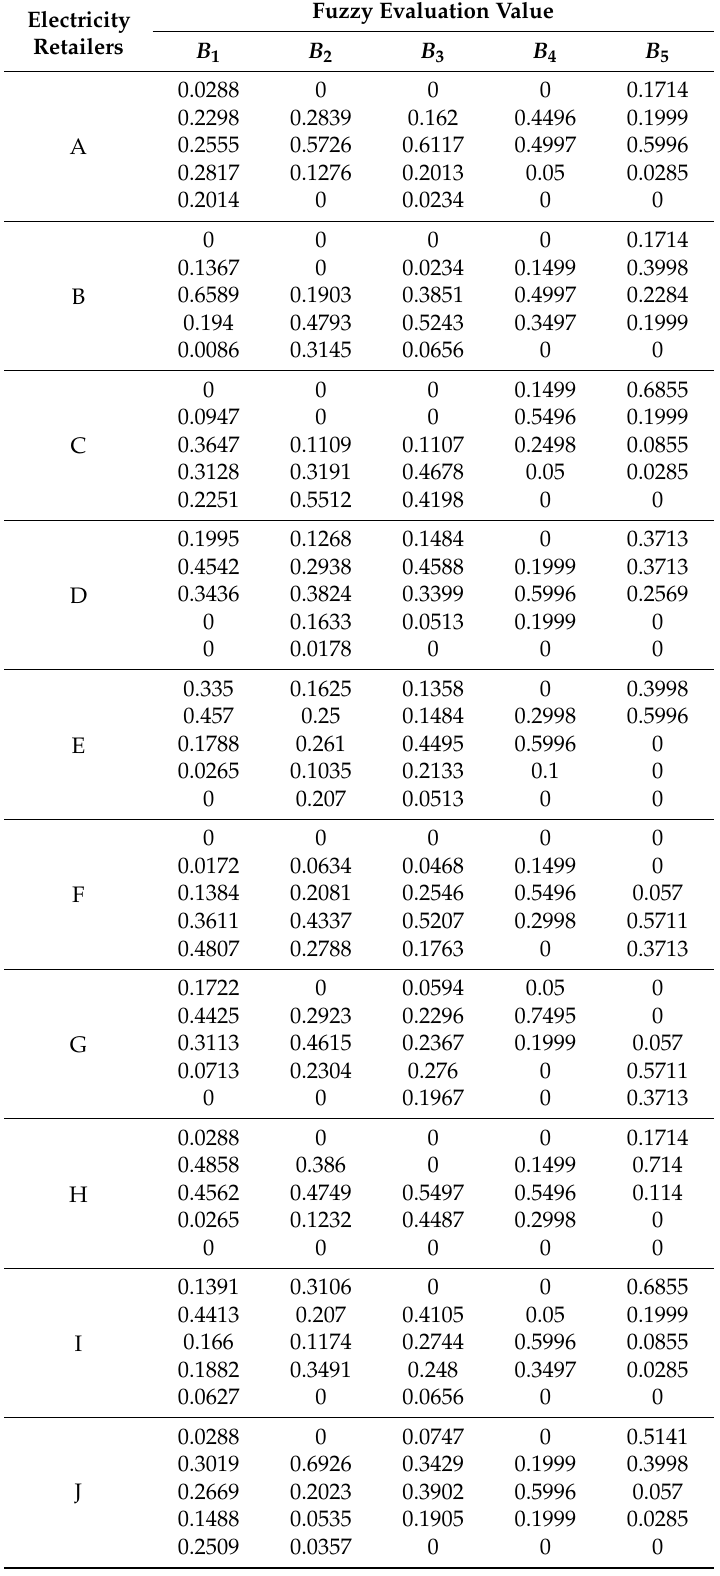
Table 8. Single-level fuzzy comprehensive evaluation